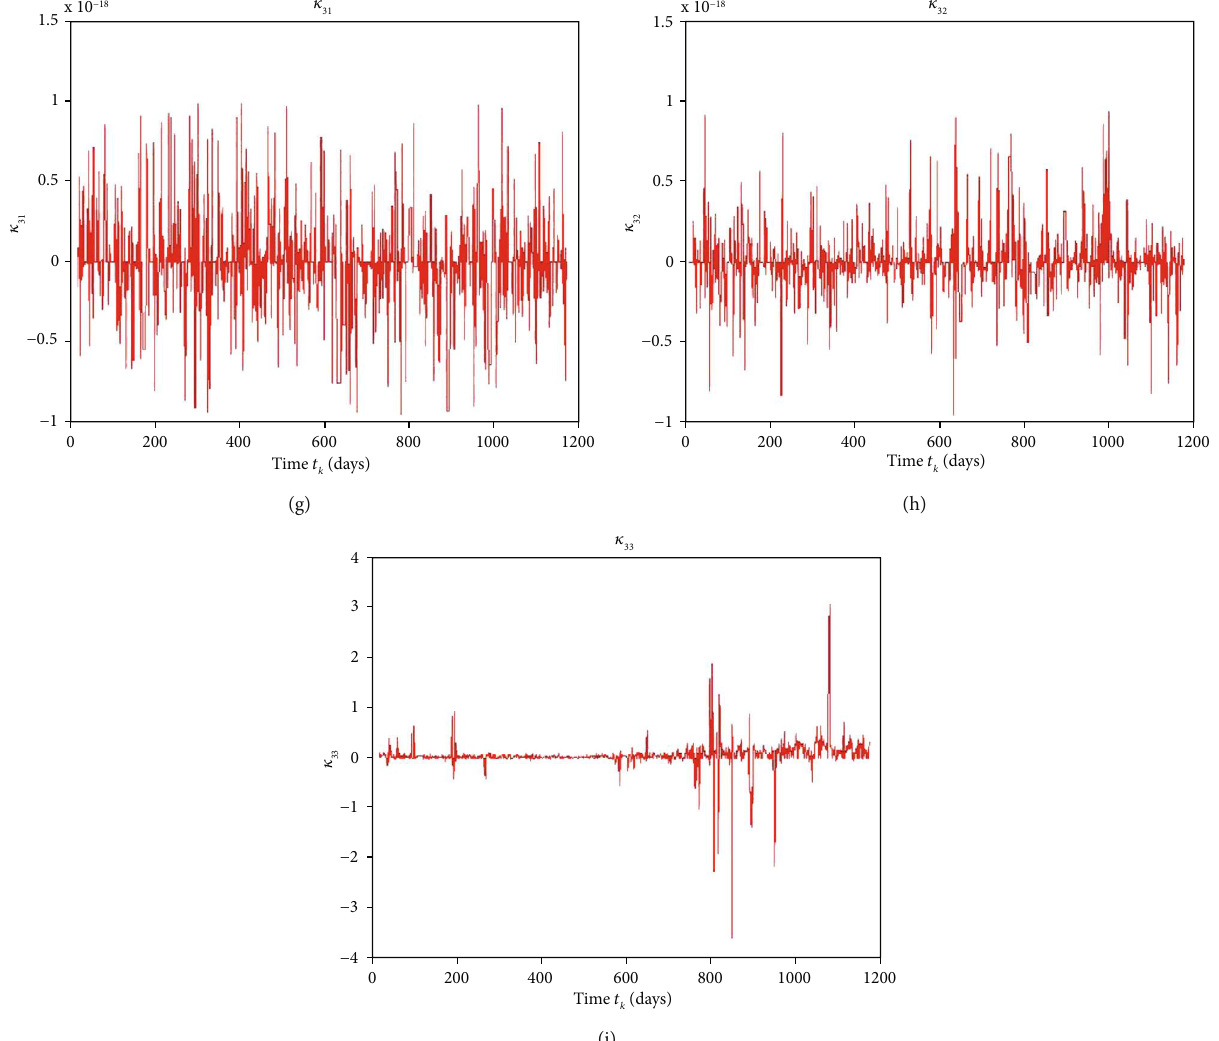
ð ̂ m , k Þ , κ 1,2 k